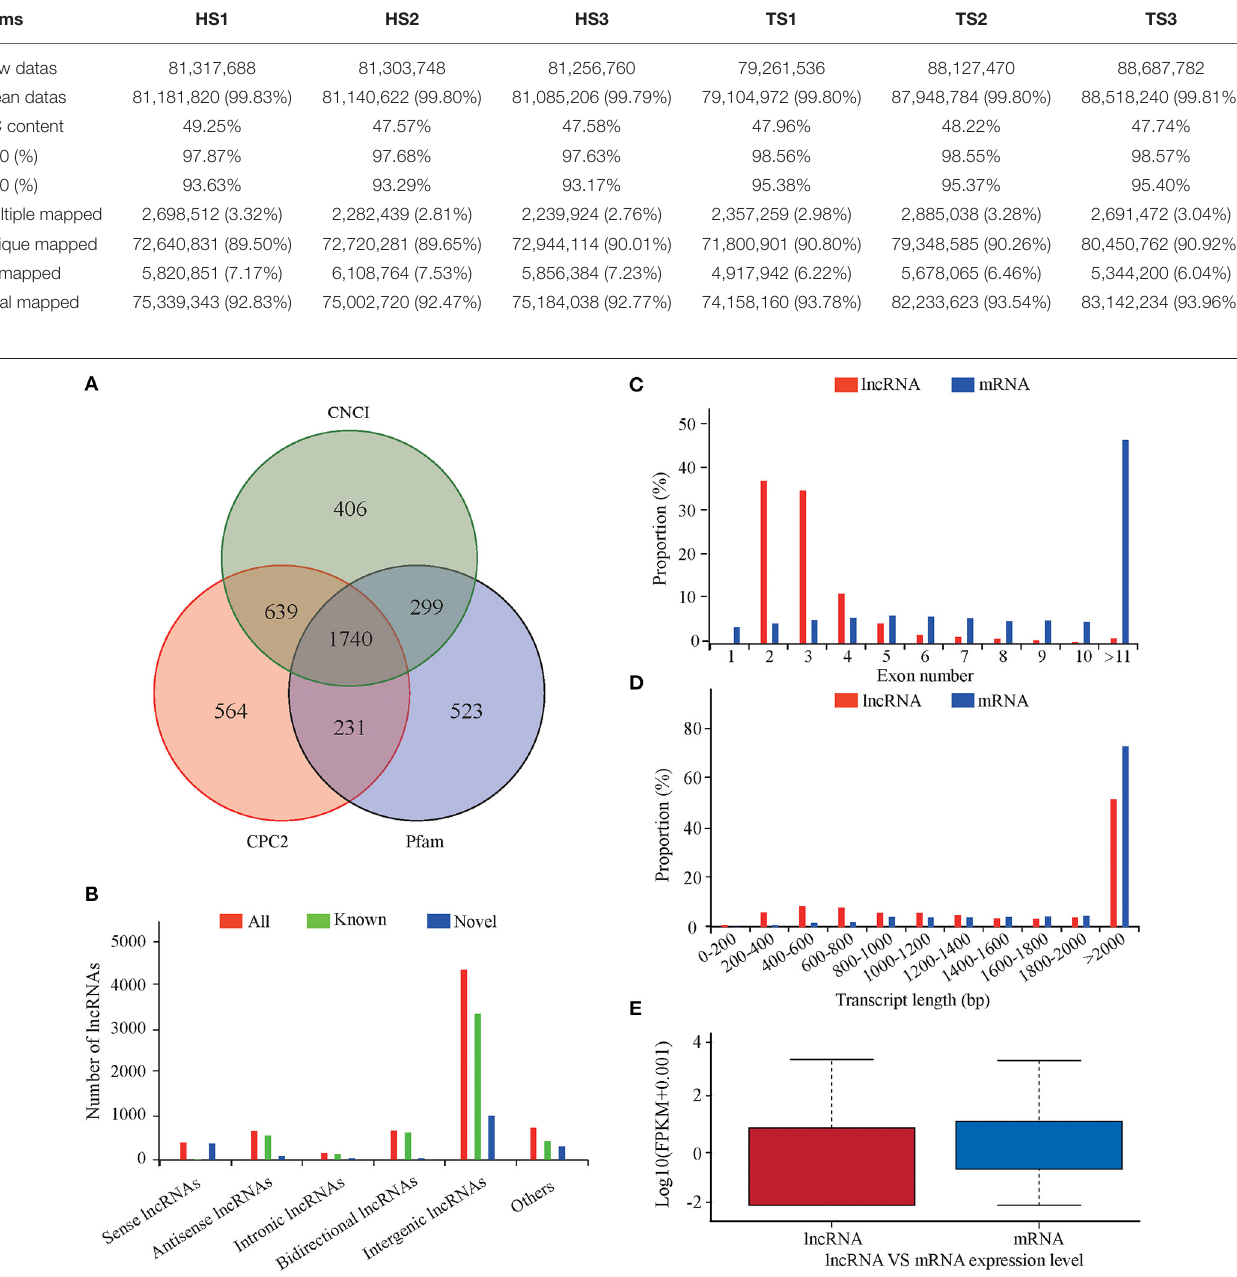
TABLE 1 | Summary of sequenced RNA-seq data.